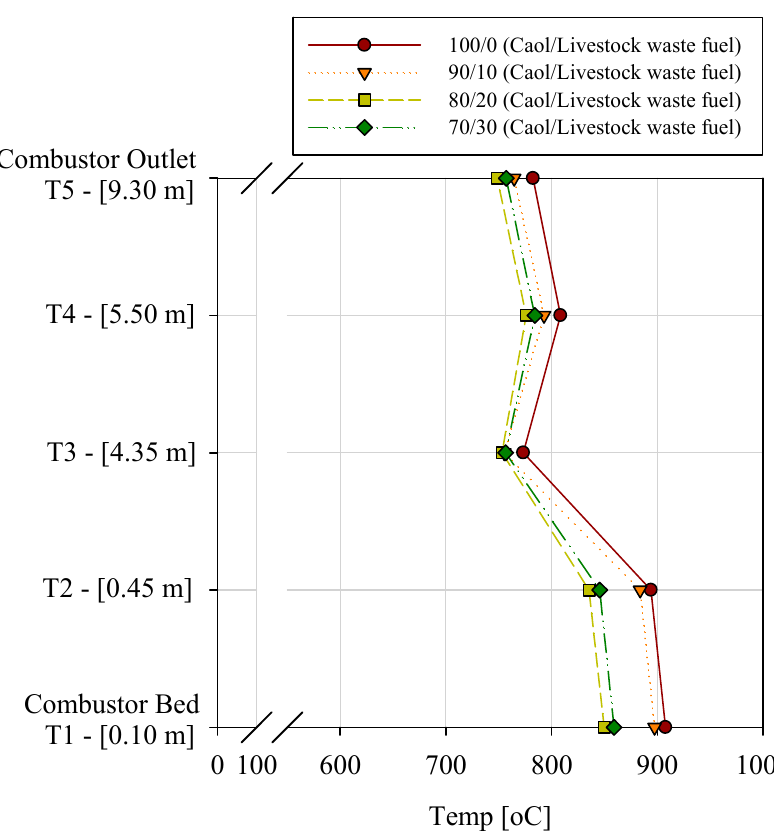
Figure 3. Combustion characteristics of livestock waste fuel at combustor.